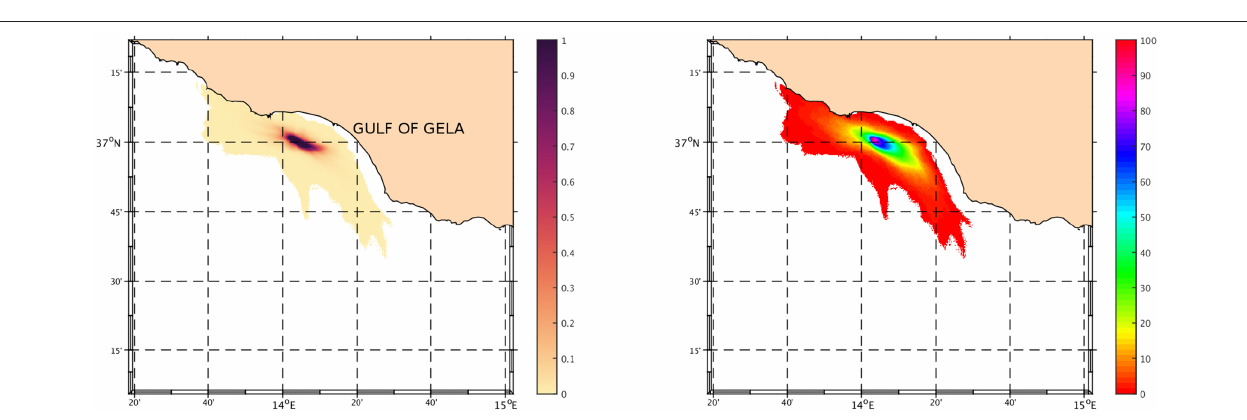
FIGURE 3 | Prezioso platform, Sicily Channel. (Left) 48 h Hazard Index, HI; (Right) 48 h Occurrence Index,